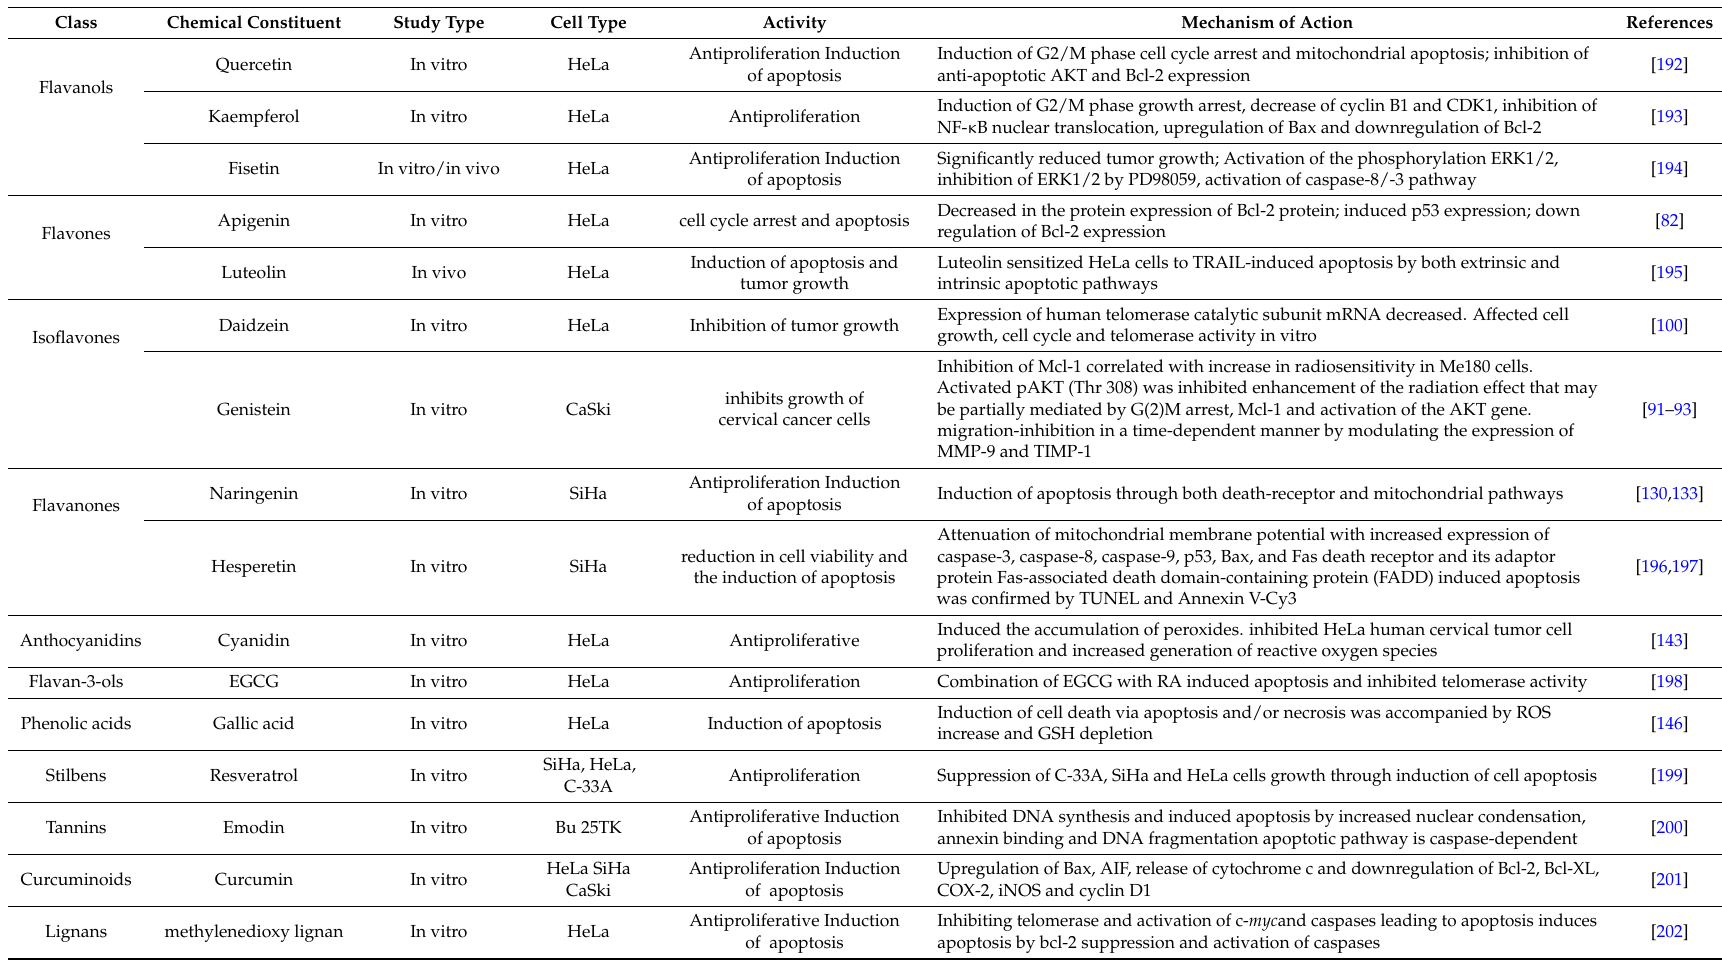
Table 2. Comparative anticarcinogenic properties of polyphenols in cervical cancer